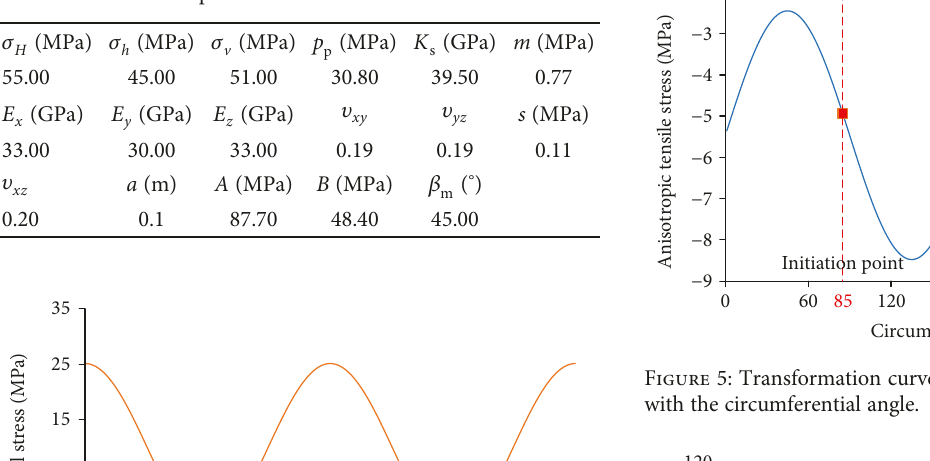
Table 1: The basic parameters used in the model calculation.